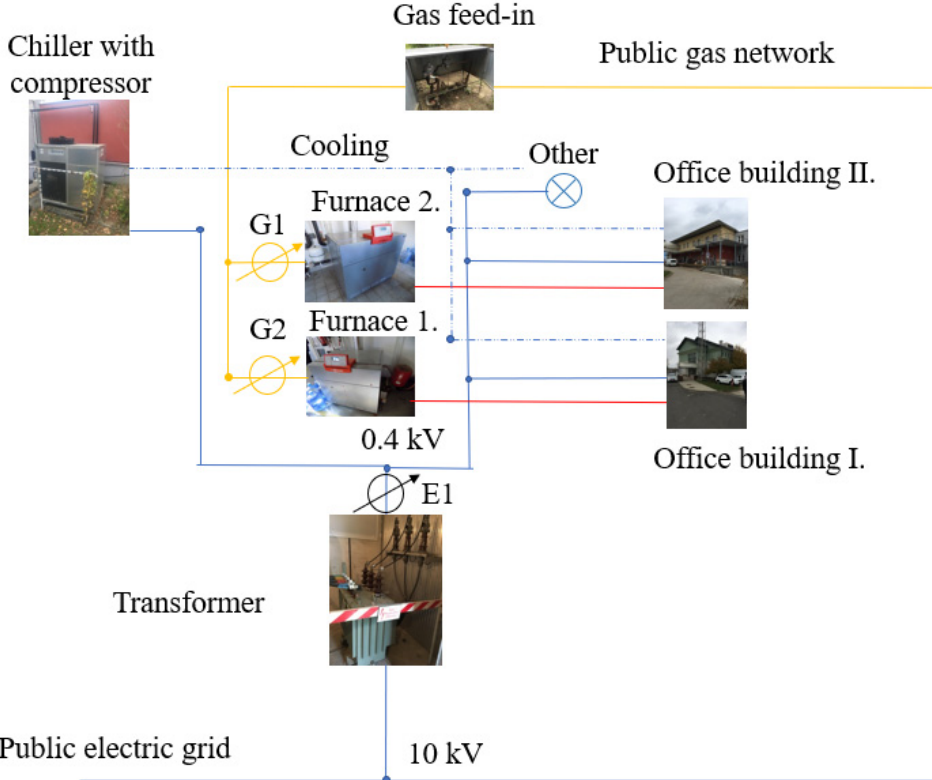
Figure 3. The present metering information level of the site.